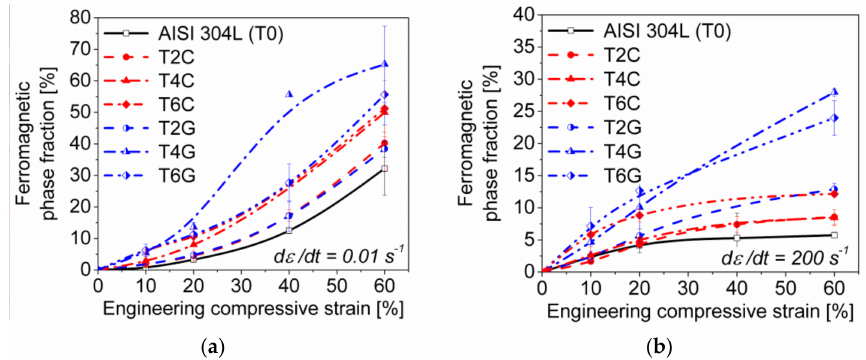
Figure 12. Ferromagnetic phase fractions ( α ’-martensite) of the TRIP-steel syntactic foams and the bulk matrix material as functions of compressive strain for ( a ) quasi-static (0.01 s − 1 ) and ( b ) dynamic impact loading (200 s − 1